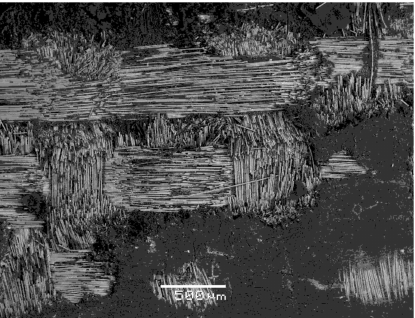
Figure 16. SEM image of the surface of the textolite material with very strong degradation effects (40 times magnification). The resin on the top layer of the material had been largely melted, charred and burned out. In the visible textile support, the fibre bundles were damaged and moved.